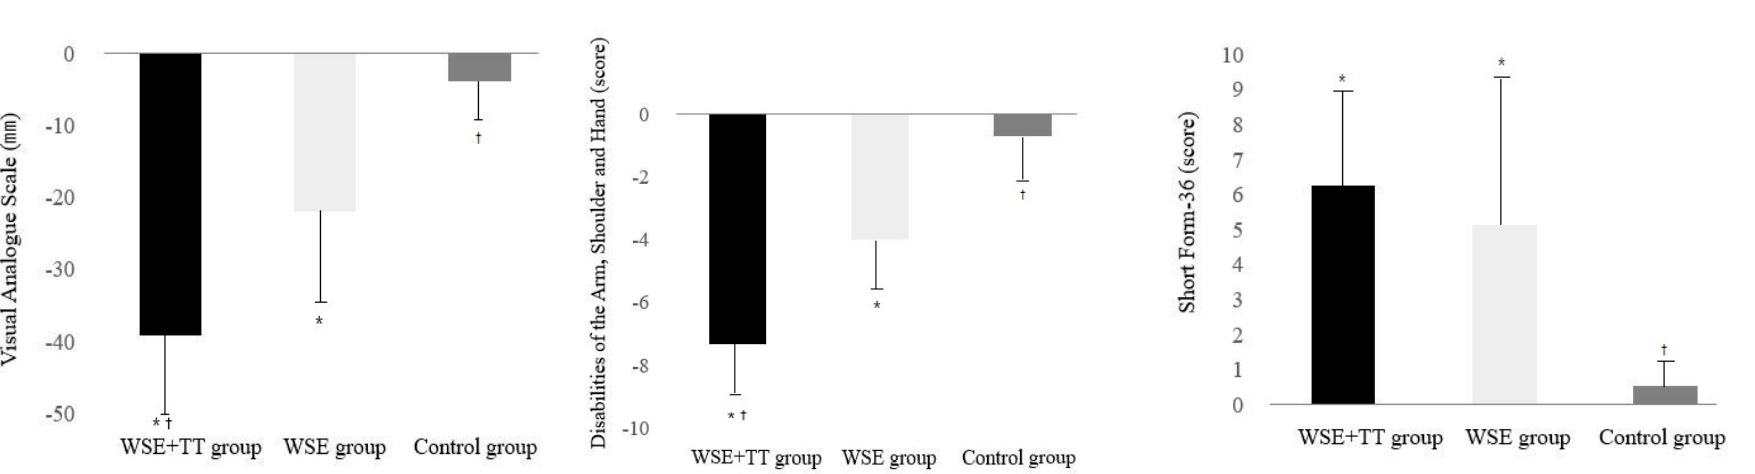
Figure 2. Changes of pain, disability, and quality of life following the intervention. * Significant difference compared to the control group ( p < 0.05). † Significant difference compared to the WSE group ( p < 0.05).